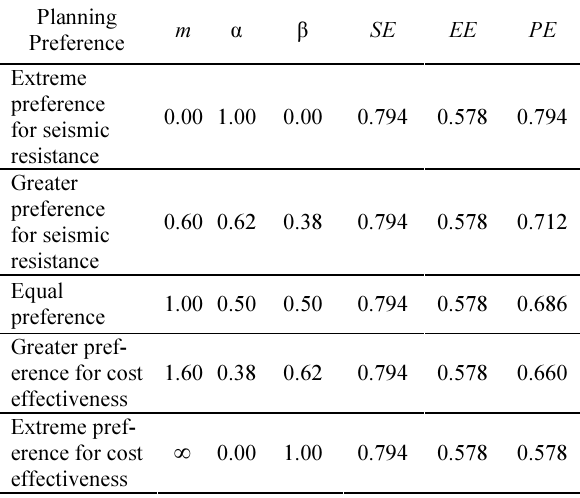
Fig. 7. Building planning efficiency